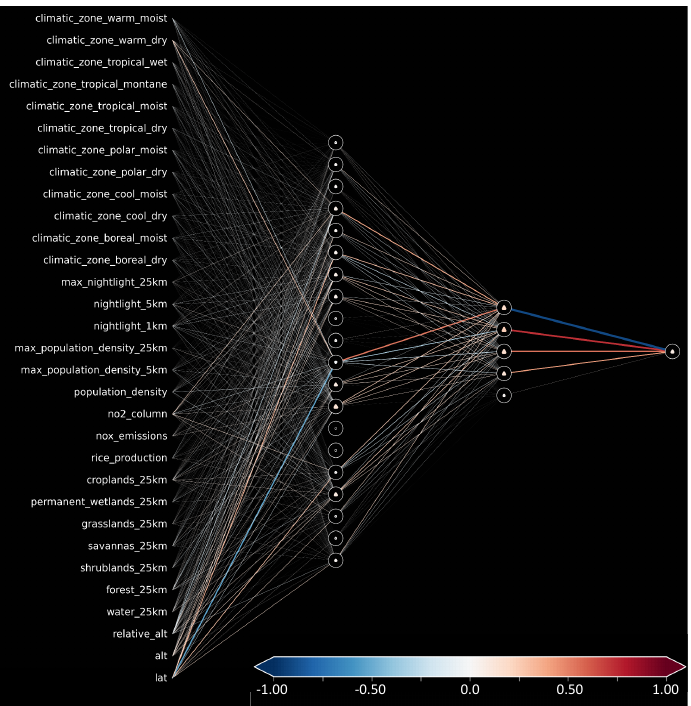
Figure A1. Weight and biases for our trained shallow neural